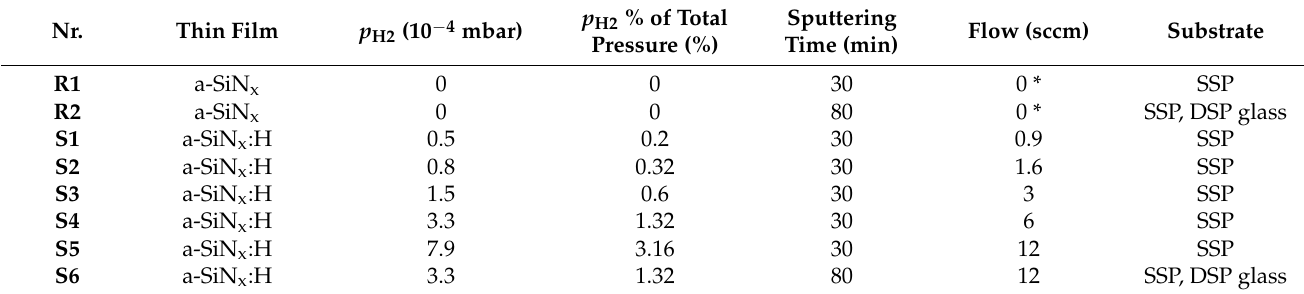
Table 1. Summary of sputtering parameters (U = 2 kV, p total = 2.5 × 10 − 2 mbar for all thin films. Single-side polished (SSP), double-side polished (DSP). * fully closed